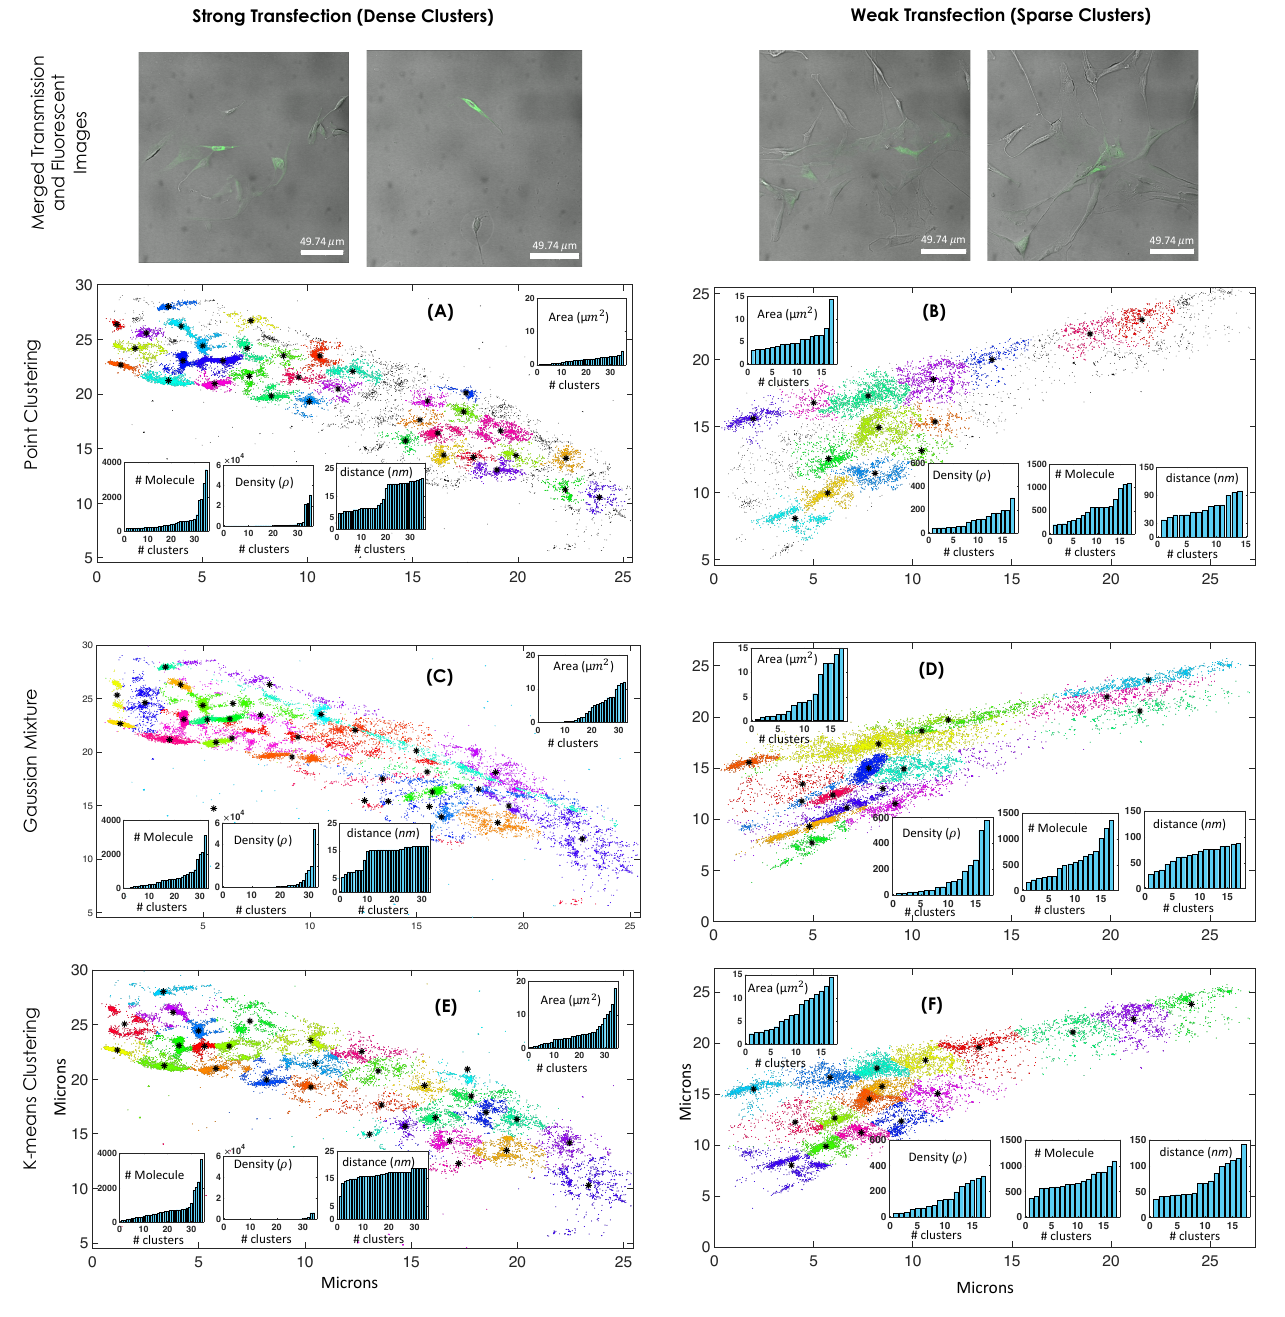
Figure 4. ( A – F ) Top row shows merged images (fluorescent and transmission images) of strong and weak transfected cells. Cluster analysis for two chosen single cells from an ensemble of Dendra- 2HA transfected NIH3T3 cell. Both strongly and weakly transfected cells are considered, which show dense and weak molecular clusters, respectively. Three different clustering methods (point clustering, Guassian mixture model, and k-means clustering) were employed to determine biophysical parameters (cluster area, cluster density, number of molecules per cluster, and pairwise-distance ). The colors are used to discern